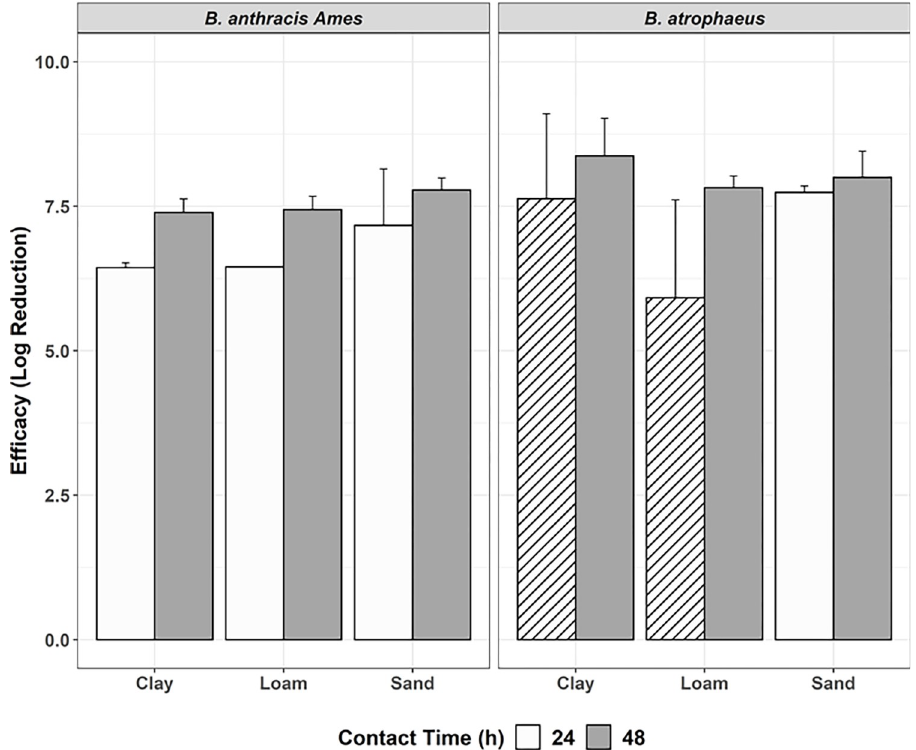
Fig 5. Efficacy of 2 mL of 2.5% formaldehyde, covered, at 10˚C with 24-hr (white; Test 6) vs. 48-hr (gray; Test 5) contact time. Tests conducted against B . a . and B . atrophaeus , with efficacy represented by log reduction ( ± 95% CI) of bacteria, by soil type, and 48-hour contact time. Columns with stripes are samples that did not achieve complete inactivation.